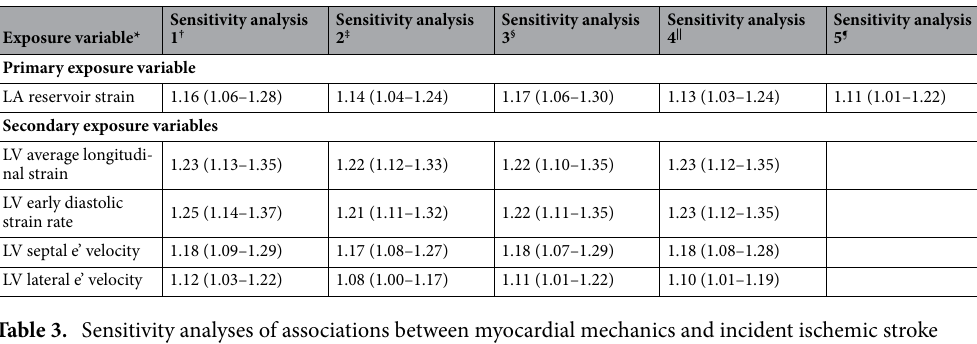
for the secondary exposure